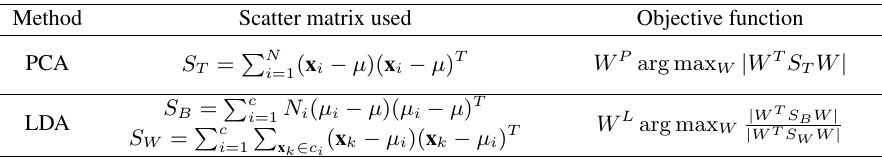
Table 1. Characteristics of PCA and